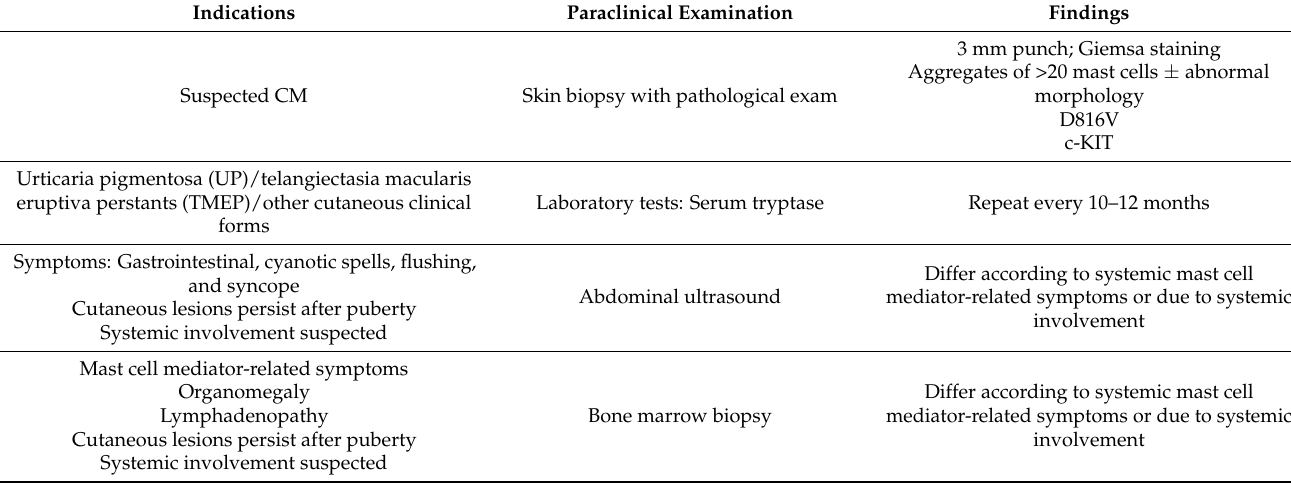
Table 1. Algorithm of cutaneous mastocytosis (CM) diagnosis in